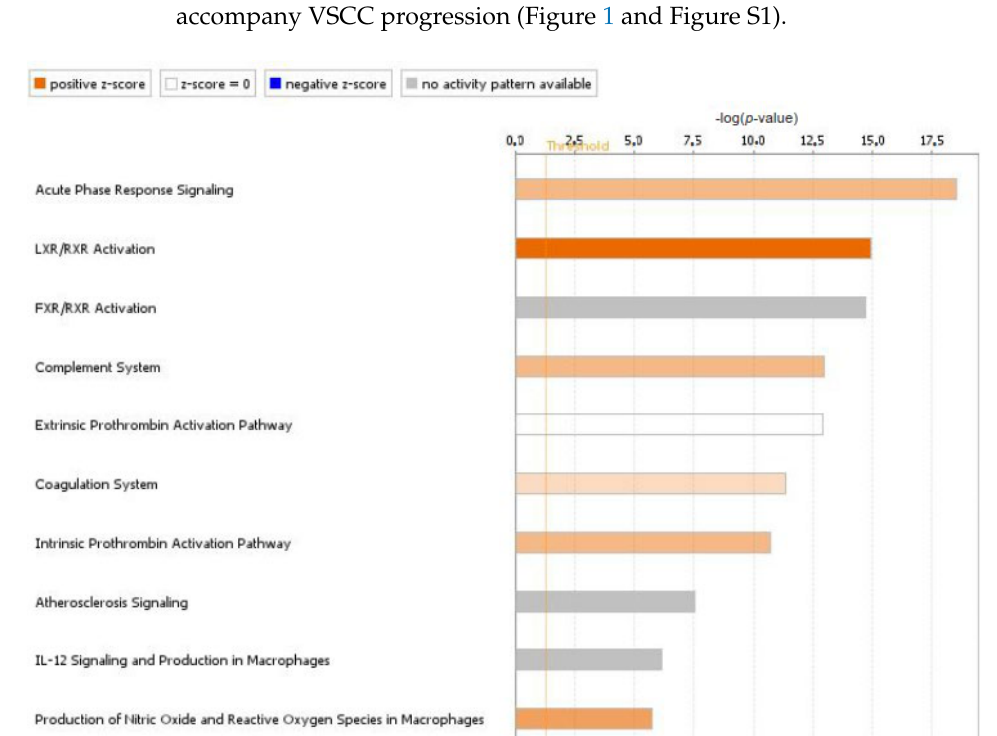
Figure 1. Top 10 canonical pathways enriched in progressed vulvar squamous cell carcinoma (progVSCC) compared to disease-free vulvar squamous cell carcinoma (d-fVSCC) tumors, identified by core analysis in Ingenuity Pathway Analysis (IPA). Top 10 canonical pathways enriched by IPA. The vertical orange line represents the threshold p -value (0.05) for pathway’s enrichment. The horizontal axis is the –log ( p -value). Pathways predicted to be activated are in orange (based on the Z-scores, the activation scores determined by IPA), and grey bars relate to pathways with no activity pattern